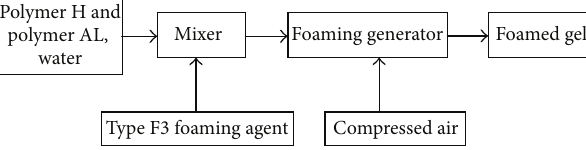
Figure 6: The flowchart for preparation of foamed